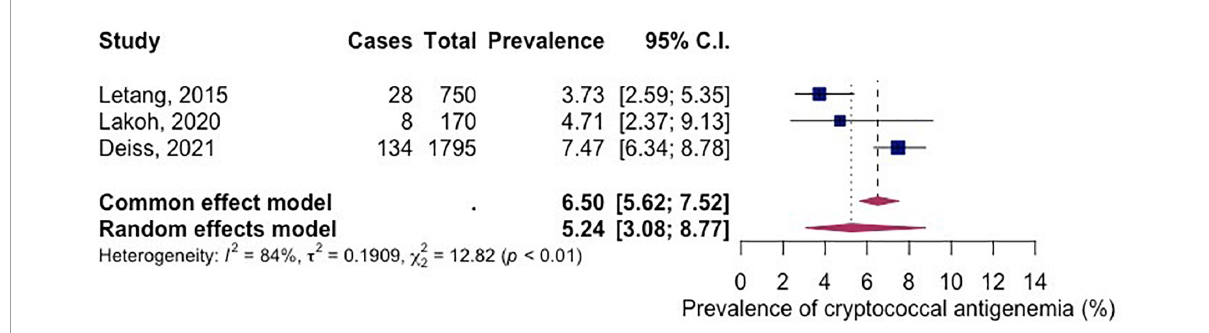
FIGURE5 Forest plot of studies included which also reported on cryptococcal antigenemia.